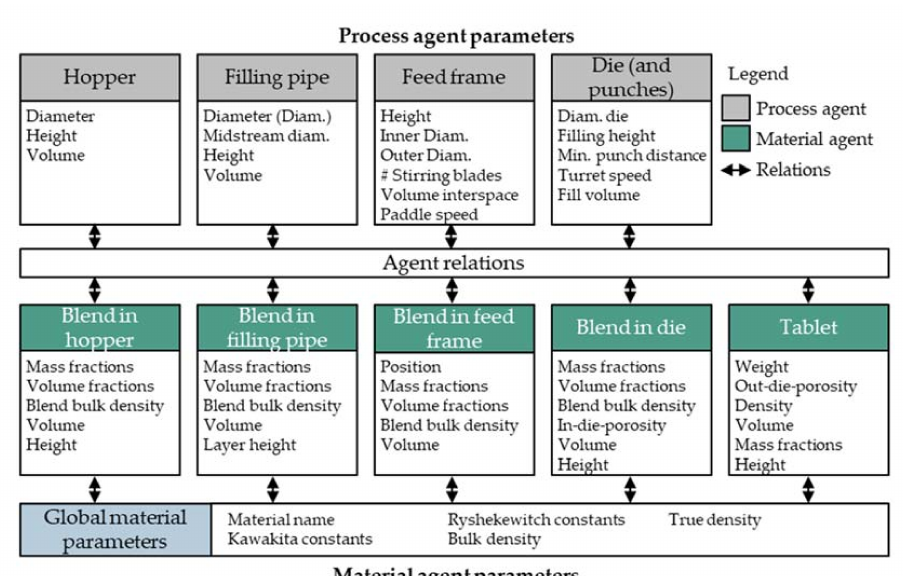
Figure 5. Existing model agents and their required